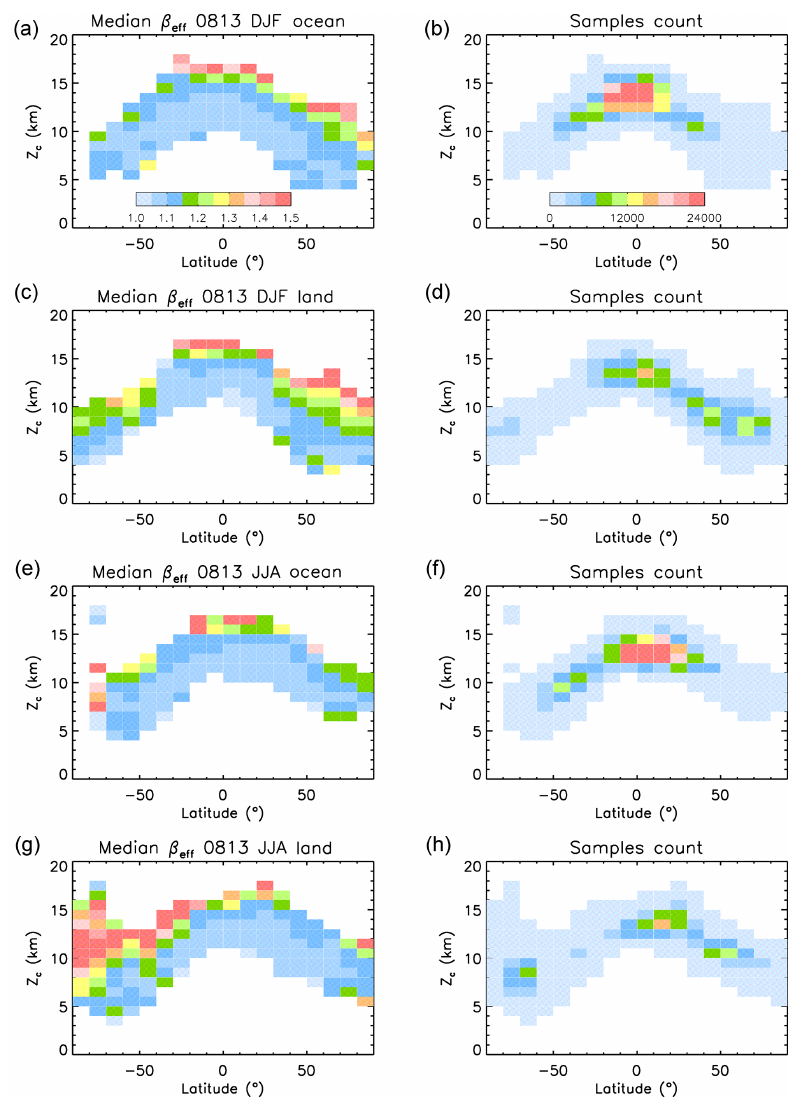
Figure 8. Median IIR β eff (a, c, e, g) and samples count (b, d, f, h) vs. latitude and representative cloud altitude, Z c , during 2008 and 2013. Panels from top to bottom are for DJF over oceans, DJF over land, JJA over oceans, and JJA over